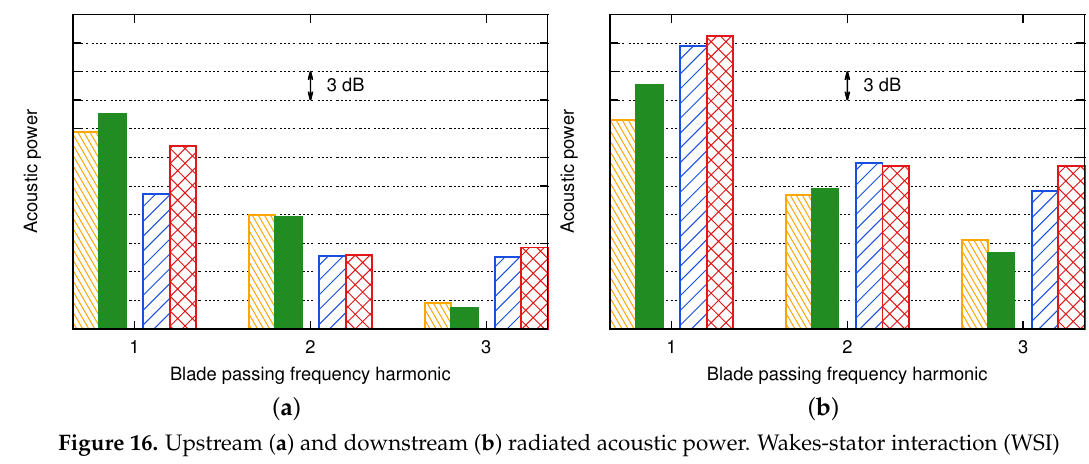
Figure 16. Upstream ( a ) and downstream ( b ) radiated acoustic power. Wakes-stator interaction (WSI) noise in the axisymmetric case in densely-hatched orange bars, WSI noise in the asymmetric case in filled green bars, distortion-rotor interaction (DRI) noise in the axisymmetric case in sparsely-hatched blue bars and DRI noise in the asymmetric case in crosshatched red